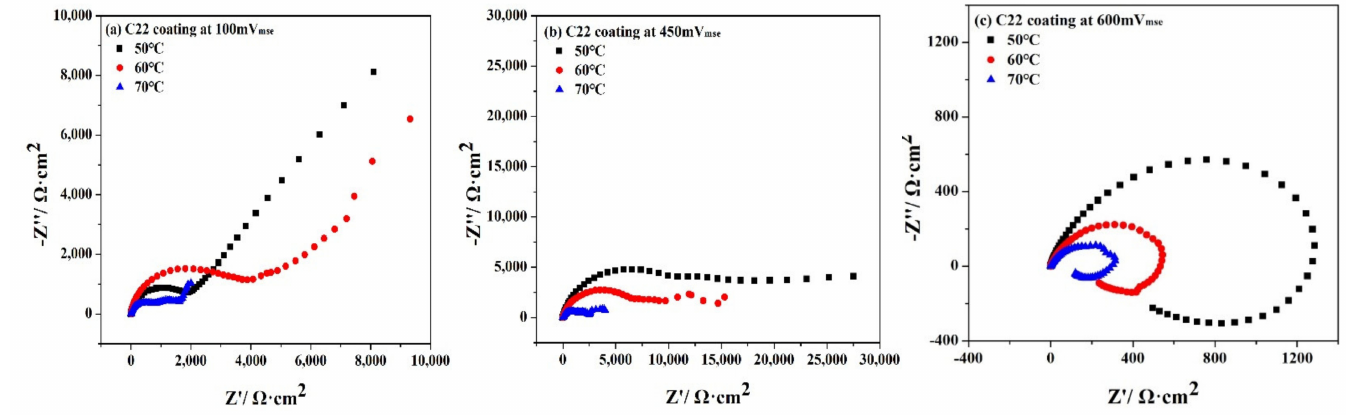
Figure 7. Nyquist plots for the C22 coating in 50 wt.% H 2 SO 4 at 100 mV mse ( a ), 450 mV mse ( b ) and 600 mV mse ( c